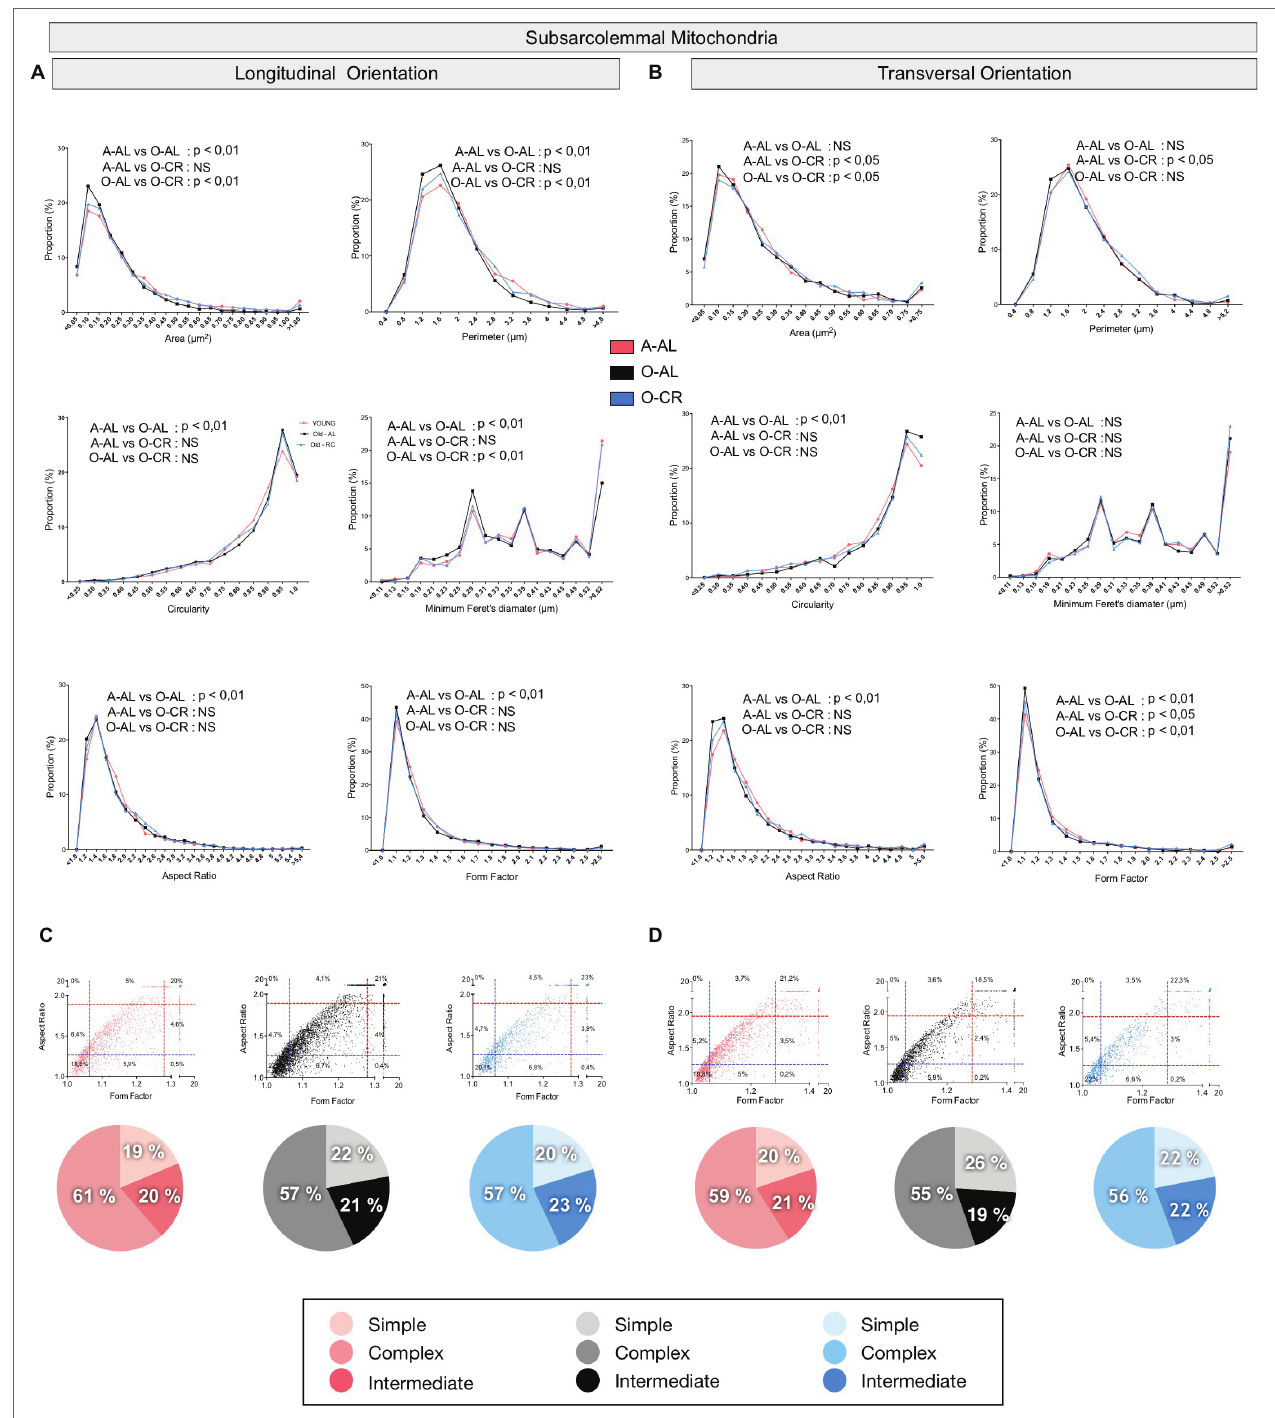
FIGURE 4 | Effect of aging and caloric restriction on the morphology of subsarcolemmal (SS) mitochondria in the oxidative SOL muscle. Analyses of morphological parameters of mitochondria SS in soleus muscle (longitudinal and transversal orientation). (A) and (B) Frequency distribution of shape descriptors and morphological for SS mitochondria in longitudinal (A) and transversal orientations (B) . (C) and (D) display the form factor and aspect ratio relationship for individual SS mitochondria for A-AL (left graph), O-AL (middle graph) and O-CR (right graph) rats in longitudinal (C) and transversal orientations (D) . In (C) and (D), blue and red dashed lines represent the 25th and 75th percentiles for either aspect ratio or form factor values of A-AL, respectively. The pie charts in the second line represent the percentage of mitochondria with simple (i.e. mitochondria with aspect ratio and form factors values inferior to the 25th percentile of A-AL values), complex (i.e. mitochondria with aspect ratio and form factors values above the 75th percentile of A-AL values) and intermediate (i.e. neither simple nor complex). Differences in frequency distributions were tested using a Kolmogorov–Smirnov test comparing cumulative